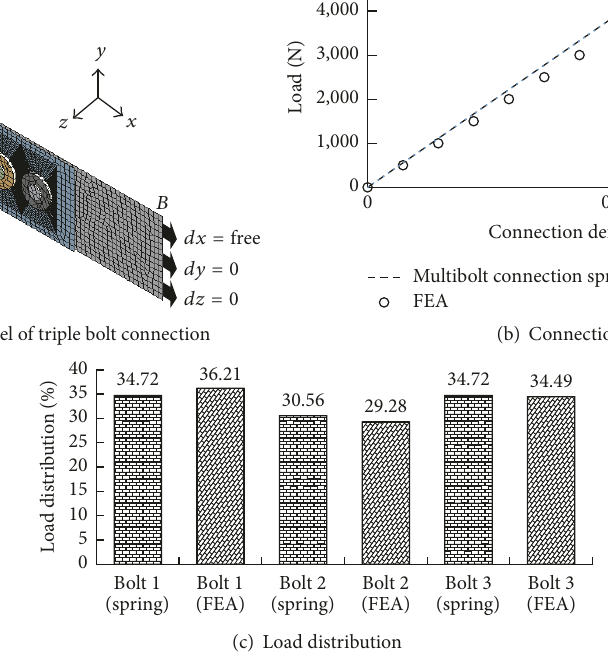
Figure 21: Connection load and load distribution of analytical model and